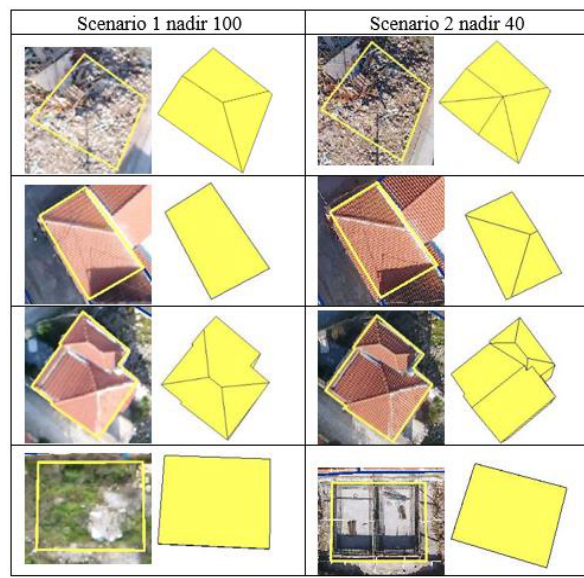
Figure 7. Errors of the 3D reconstruction of some footprints The visualization of LOD2 buildings (Figure 8) was made in ArcGIS ArcScene and FZK Viewer (KIT). Specifically, the LOD2 buildings were transformed in COLLADA format as separate buildings and were visualized in ArcScene and in CityGML format were rendered in FZK Viewer.